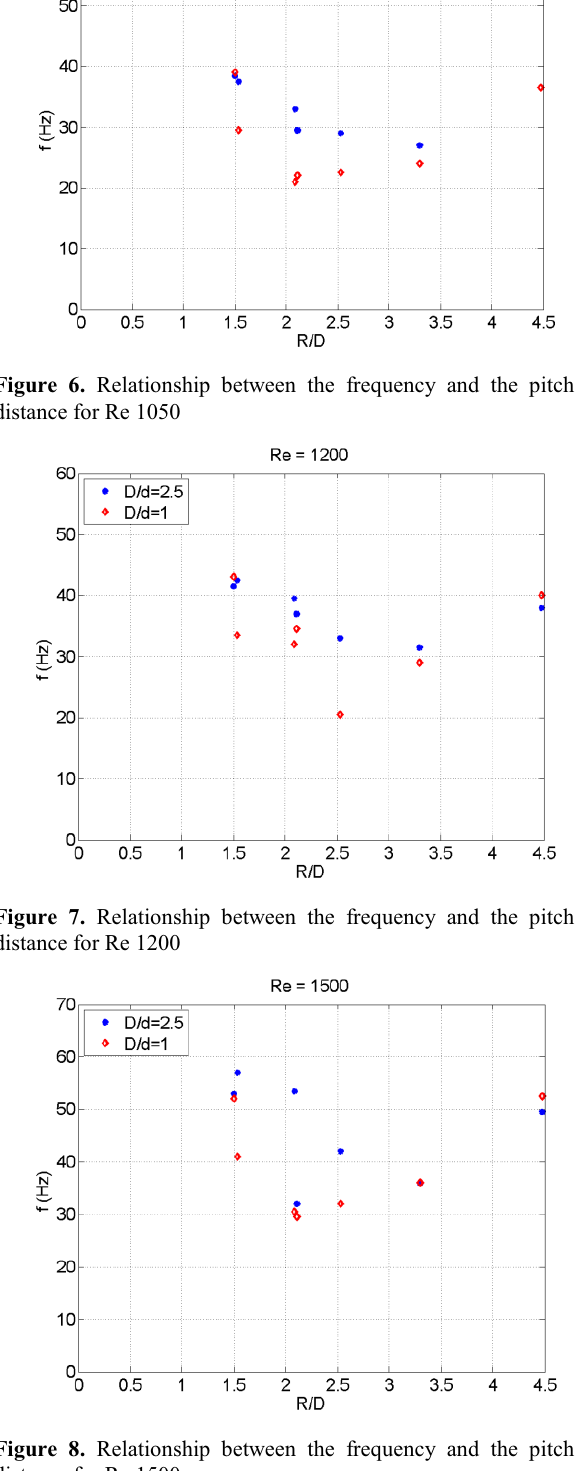
Figure 8. Relationship between the frequency and the pitch distance for Re 1500